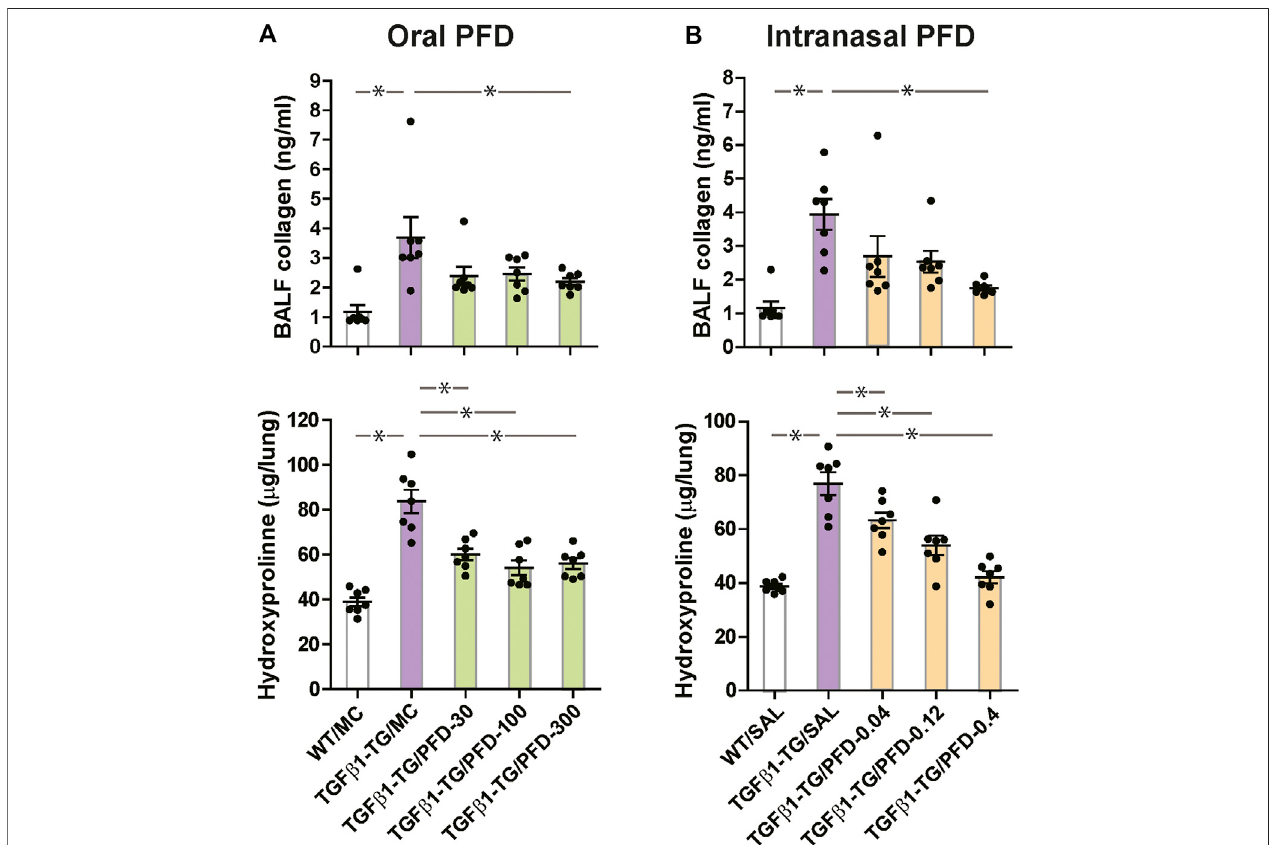
FIGURE5| Signi fi cantreductionincollagendepositionmarkersinthelungsfrommicetreatedwithpirfenidone (PFD)byoralorintranasal administrationcompared to controls. Human transforming growth factor (TGF) β 1 transgenic (TG) mice were allocated in groups treated with PFD by oral ( A ; n (cid:2) 7) or intranasal ( B ; n (cid:2) 7) administration and in groups treated with the vehicle saline (SAL; n (cid:2) 7) or with the vehicle methylcellulose (MC; n (cid:2) 7) twice a day for 21 days and once a day on day 22 beforeeuthanasia.Wildtype(WT; n (cid:2) 7)micetreatedwithsalineorMCwereusedasnegativecontrols.Dataareexpressedasthemean ± S.E.M.Statisticalanalysis by Student ’ s t -test and ANOVA with Dunnett ’ s post hoc test. * p < 0.05.